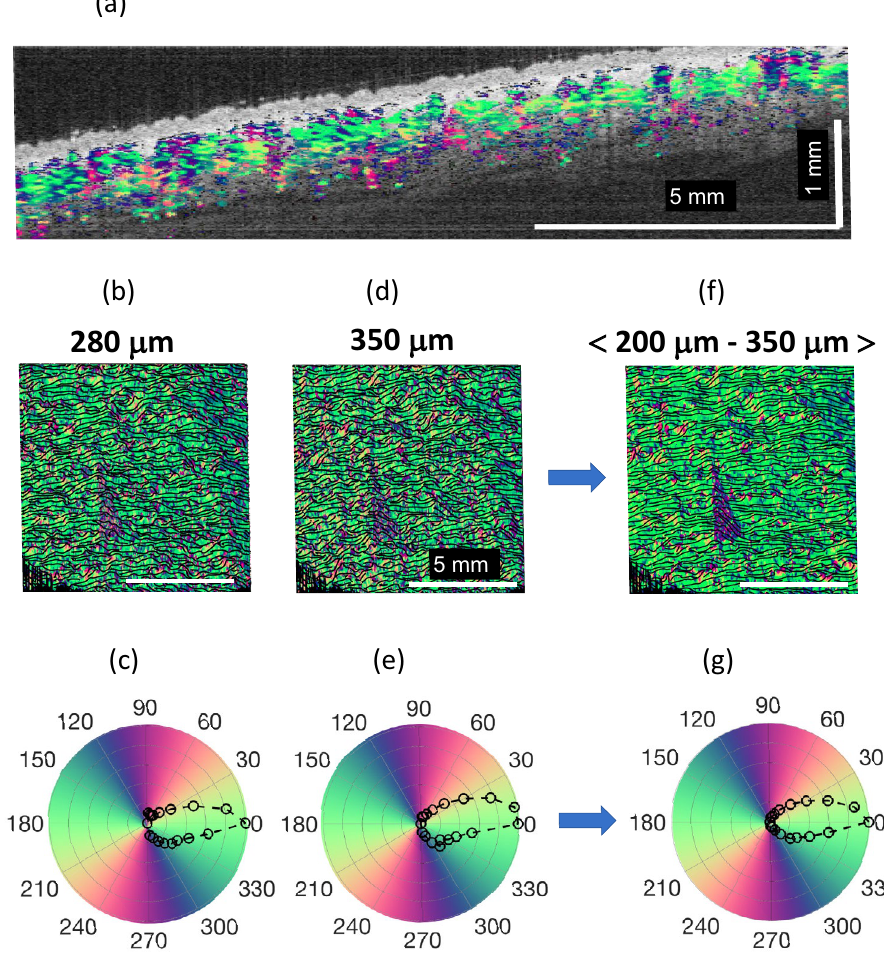
Figure 3. Optical polarization maps in skin (forearm body area, Subject #4). PS-OCT measurements were performed at the same body sites to compare with AμT-OCE. ( a ) Cross-sectional OCT image with the depth- resolved optic axis orientation measurement superimposed. ( b ), ( d ), ( f ) Color-encoded en-face slices (i.e., C-Scan) of the apparent optic axis at different depths in skin (depths are shown at the top of panels), and ( c ), ( e ), ( g ) present in-plane optic axis patterns averaged over skin maps for the same depths. Last panels ( f ) and ( g ) are obtained by averaging optic axis orientations over the entire depth in dermis. A piece of triangular black tape was used to align PS-OCT relative to AμT-OCE